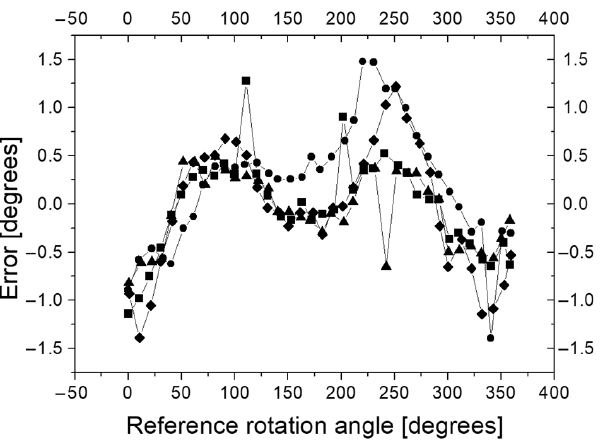
Figure 13. Angular differences (error) between readings D2 and reference frame R1. The different symbols correspond to four series of experiment.